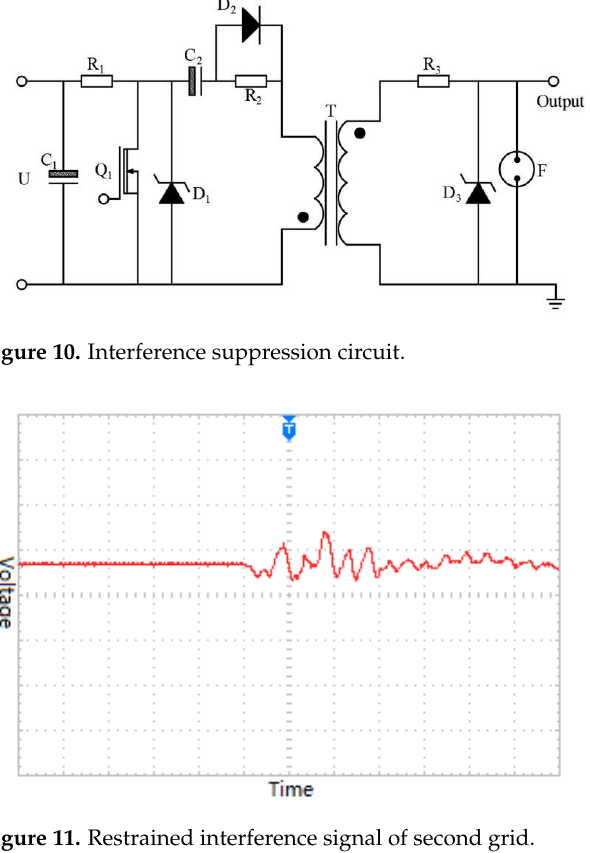
Figure 10. Interference suppression circuit.